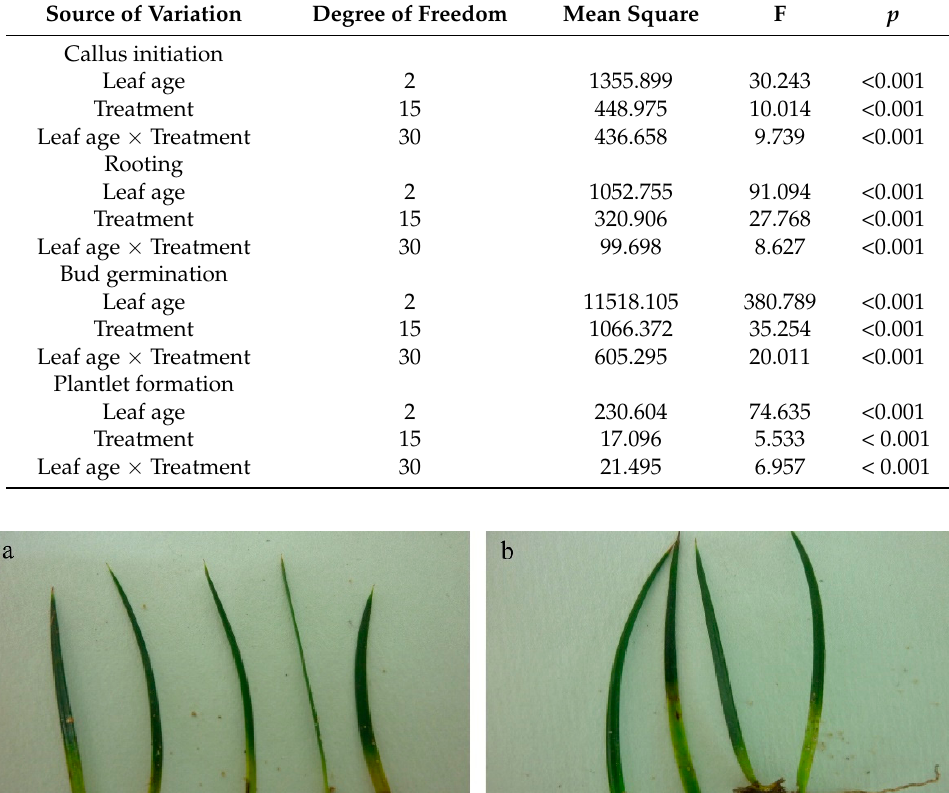
Table 2. Summary of two-way ANOVA for the main effects of leaf age and treatment, and their interaction on callus initiation, rooting, bud germination, and plantlet formation of Chinese fir leaf cuttings.